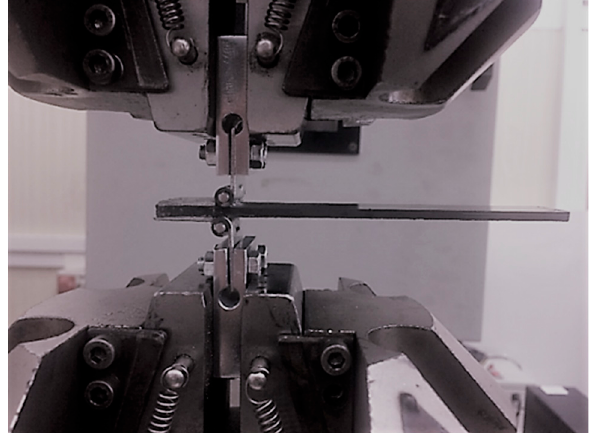
Figure 2. Specimen gripping for mode I delamination tests.